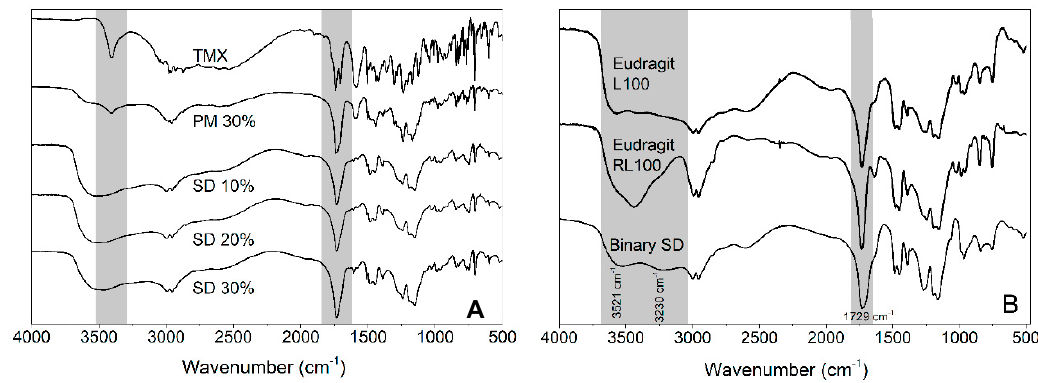
Figure 4. ( A ) Fourier-transform infrared (FTIR) spectra of isolated TMX, PM 30%, SD 10%, SD 20%,